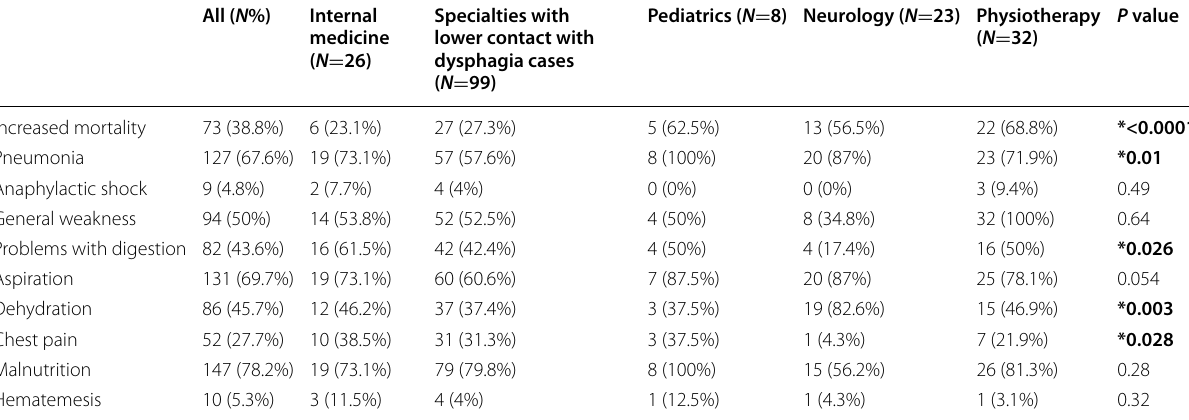
*Significant P value <